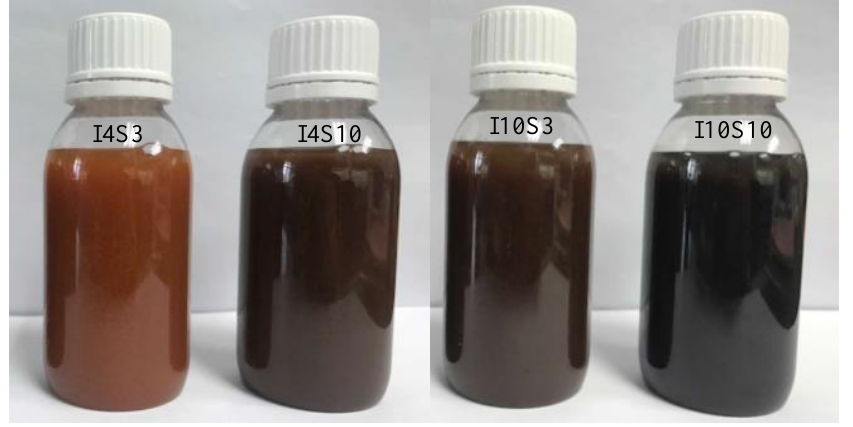
Figure 3. Suspensions recycled from NaCl electrolyte.